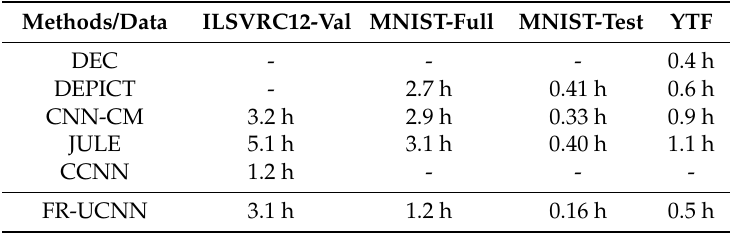
Table 6. Computational Time Comparison of FRUCNN with compared